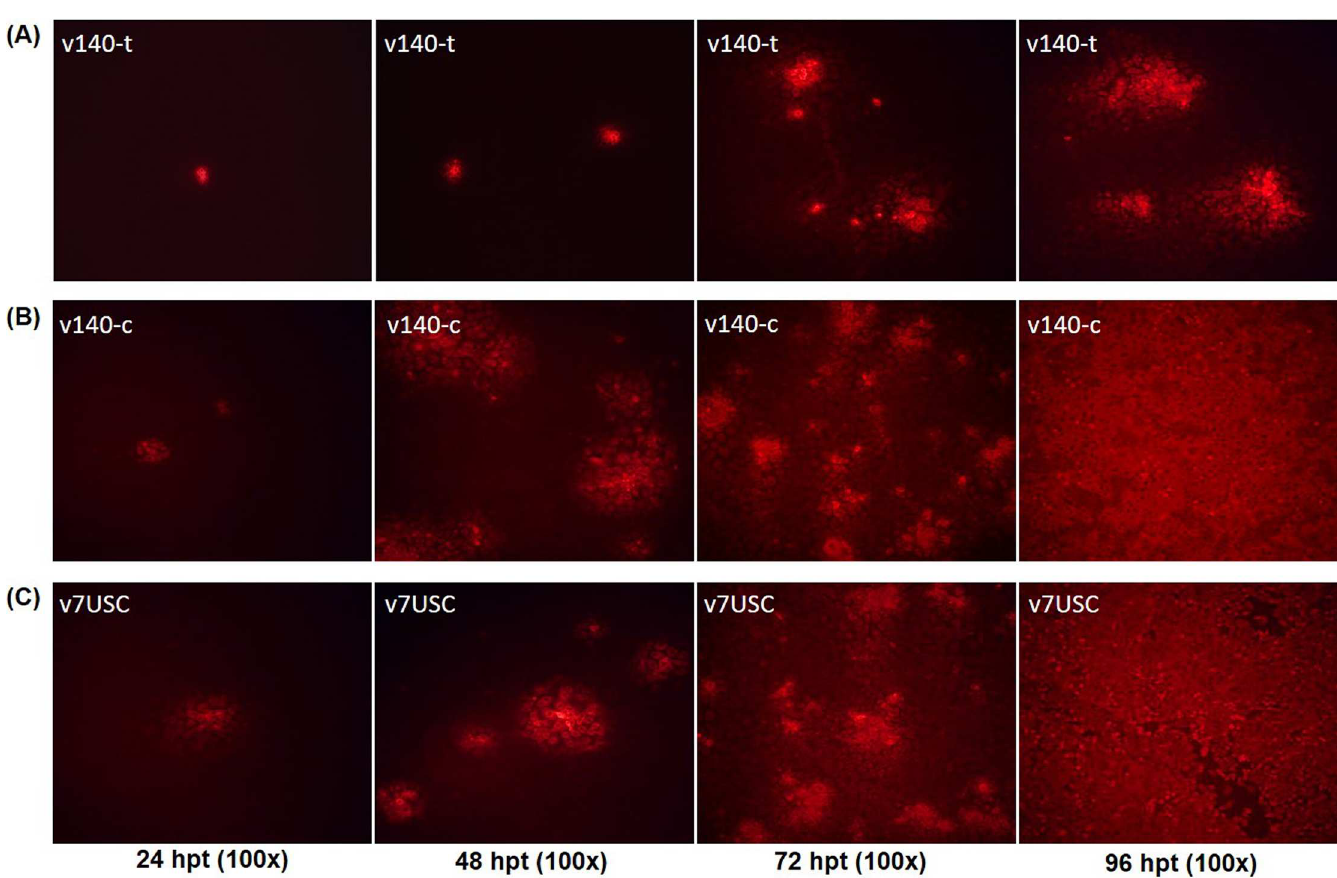
Fig 6. Virological characteristics of mutants. Intracellular N-protein expression of A : v140-t and B: v140-c at the indicated times (24 hpt, 48 hpt, 72 hpt, and 96 hpt), with C: v7USC was used a control. Cells were fixed and immunostained with the mouse monoclonal SR30A antibody against the viral N protein and fluorescein isothiocyanate-conjugated goat anti-mouse